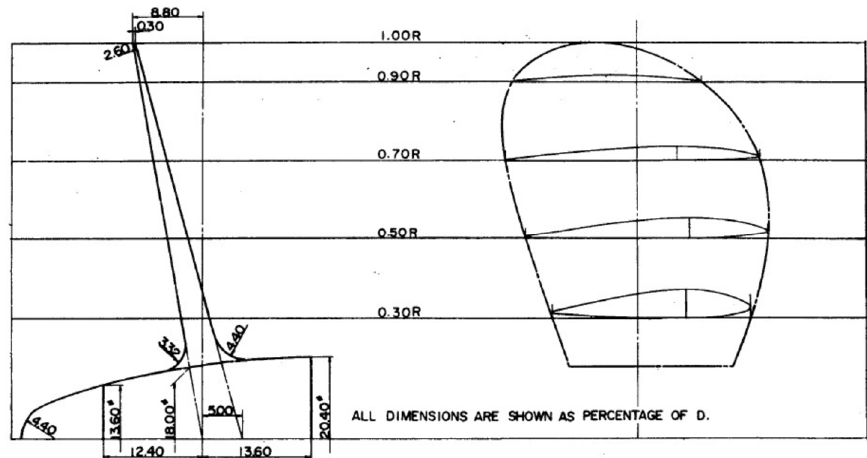
Figure 3. General plan of Kaplan 19A series [14].